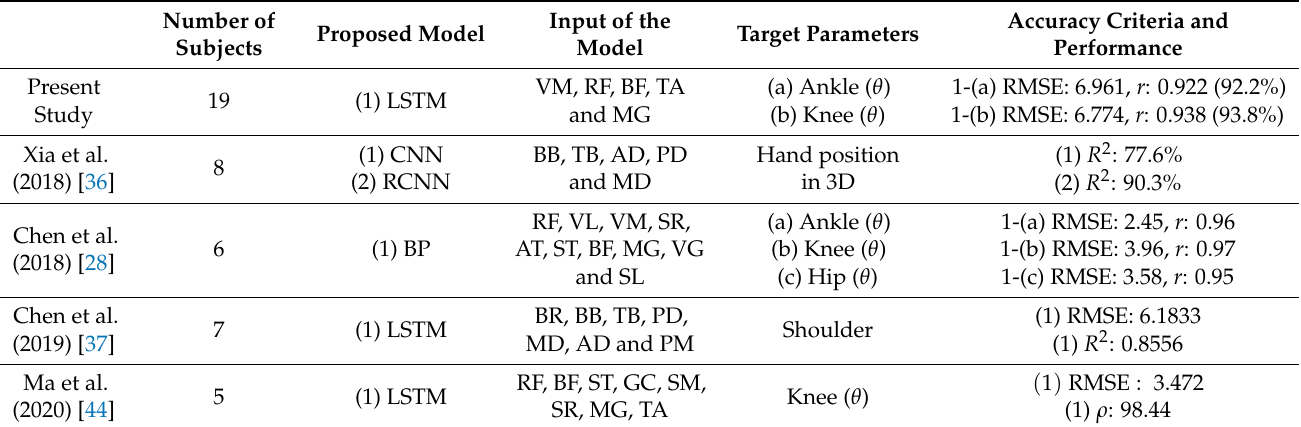
Table 3. Previous studies and their